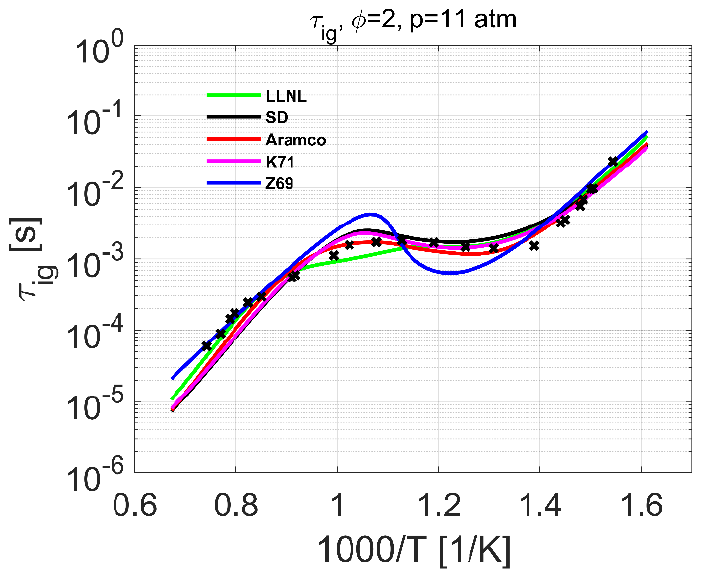
Figure A2. Ignition delay time for DME-air mixtures at 11 atm and ϕ = 2.0. Legend: experimental data for τ ig from (×) Burke et al. [17]. Mechanism predictions from Z69 in blue, LLNL in green [28], Aramco in red [17], K71 in magenta [32] and San Diego in black [30].